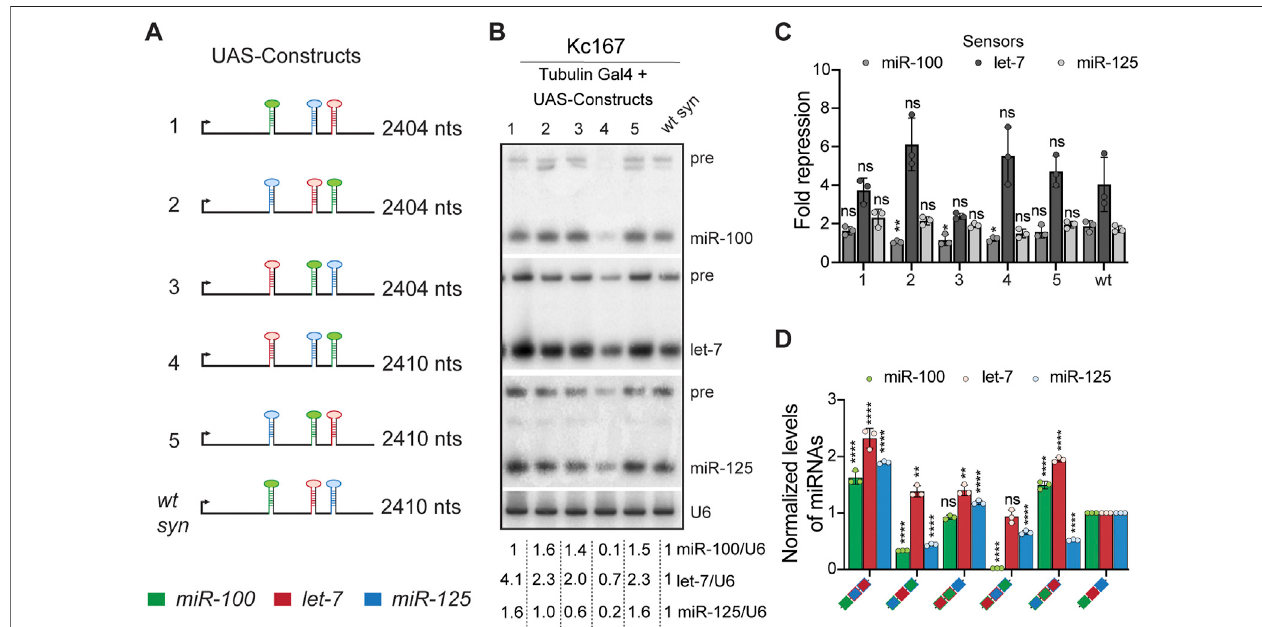
FIGURE 1 | Positional context determines the processing of let-7-Complex ( let-7-C ) miRNAs. (A) Schematic representation of the UAS let-7-C constructs describedinthe fi gurepanels (B – D) . (B) SmallRNAnorthernblotanalysisofKc167cellstransfectedwithTubulinGal4and UASlet-7-C expressionplasmidsindicatedin (A) . Total RNA was extracted from Kc167 cells 72 h post-transfection. 10 μ g of total RNA was resolved on three 15% urea-polyacrylamide gels and transferred onto hybridization membranes and probed for miR-100 , let-7 and miR-125 . U6snRNA was used as a control for normalization and normalized levels of processed miRNAsareindicatedbelowthegel. (C) Foldrepressionof miR-100 (mediumgreybar), let-7 (darkgreybar)and miR-125 (lightgreybar)luciferasesensorsinKc167cells transfected with UAS let-7-C cDNA constructs in (A) . Assays were performed in triplicates. Data are represented as mean ± SD, n = 3. p -value calculated by ordinary one-way ANOVA for miR-100 sensor is 3.30E-07; for let-7 sensor is 1.25E-09; and for miR-125 sensor is 1.91E-03. Adjusted p -values after applying Bonferroni ’ s correction are represented in the fi gure panel and we used an α level of 0.05 to assess statistical signi fi cance. (D) Expression of miR-100 (green bar), let-7 (red bar), and miR-125 (blue bar) in transgenic lines expressing UAS let-7-C cDNA under the control of let-7-C Gal4 knock-in driver ( G4KI ) as determined by Taqman miRNA assays. The expression plasmids are variants of the let-7-C cDNAs where the position of miR-100, let-7 and miR-125 are interchanged and the changes are indicated in the color-codedlegend. Total RNAwasextractedfromadult fl iesthatwereinatrans heterozygote let-7-C nullmutantofthefollowing genotype: let-7-C GKI / let-7-C KO2 ; UAS transgene/+ . Assayswereperformedin triplicates. Dataare represented asmean ±SD, n = 3. p -valuecalculatedby ordinary one-way ANOVA formiR-100is1.06E-12; forlet-7is7.19E-09;andformiR-125is < 1.00E-15.Adjusted p -valuesafterapplyingBonferroni ’ scorrectionarerepresentedinthe fi gurepanelandweusedan α levelof 0.05 to assess statistical signi fi cance. 2S rRNA was used as a control for normalization. Genotype of strains used: (1D) w 1118 ; let-7-C GKI /let-7-C KO2 ,